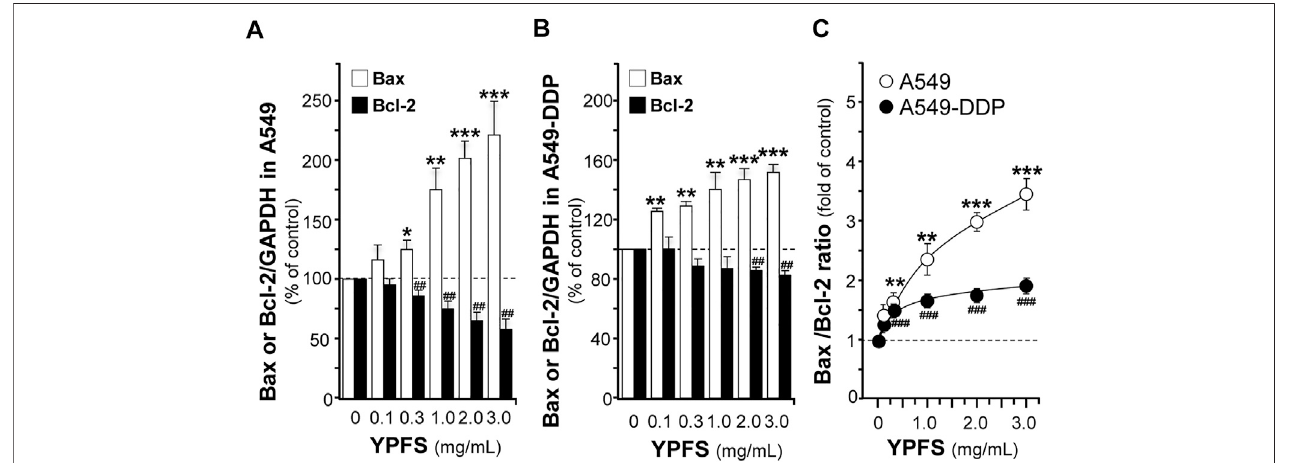
FIGURE 7 | YPFS alters gene expressions of Bax and Bcl-2 in cultured A549 and A549-DDP cells. Cultured A549/A549-DDP cells (120,000/well in 6-well plate) were treated with YPFS for 24 h. The expression levels of target proteins were revealed by quantitative real-time PCR. The transcript levels of Bax and Bcl-2 in cultured A549 (A) andA549-DDPcells (B) .Bax/Bcl-2ratio (C) inculturedA549andA549-DDPcells.Valuesareinmean ± SEM, n (cid:2) 3.*or # , p < 0.05,**or ## , p < 0.01,***or ### , p <